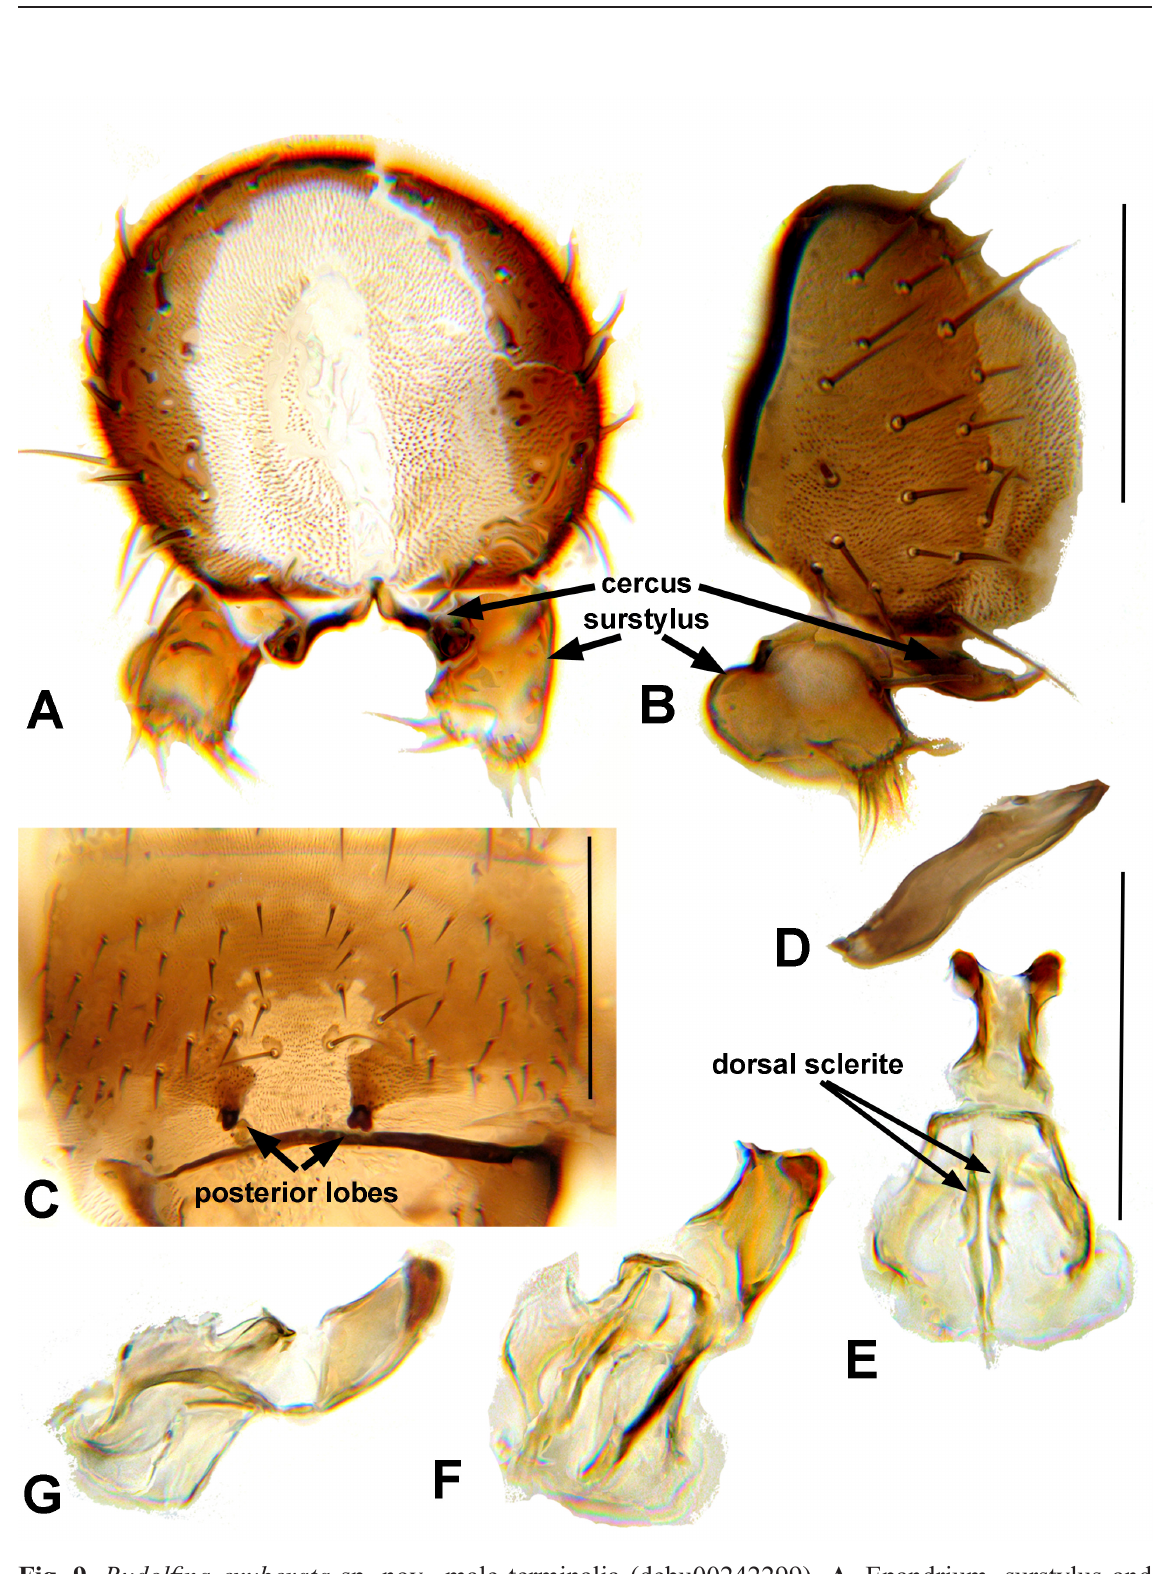
Fig. 9 . Rudolfina exuberata sp. nov., male terminalia (debu00242299). A . Epandrium, surstylus and cercus, caudal view. B . Same as preceding, lateral view. C . Sternite 5, ventral view. D . Postgonite, close up lateral view. E . Phallus, dorsal view. F . Same as preceding, dorsolateral view. G . Same as preceding, lateral view. Scale bars: A–B = 0.10 mm; C = 0.10 mm; D–F = 0.10